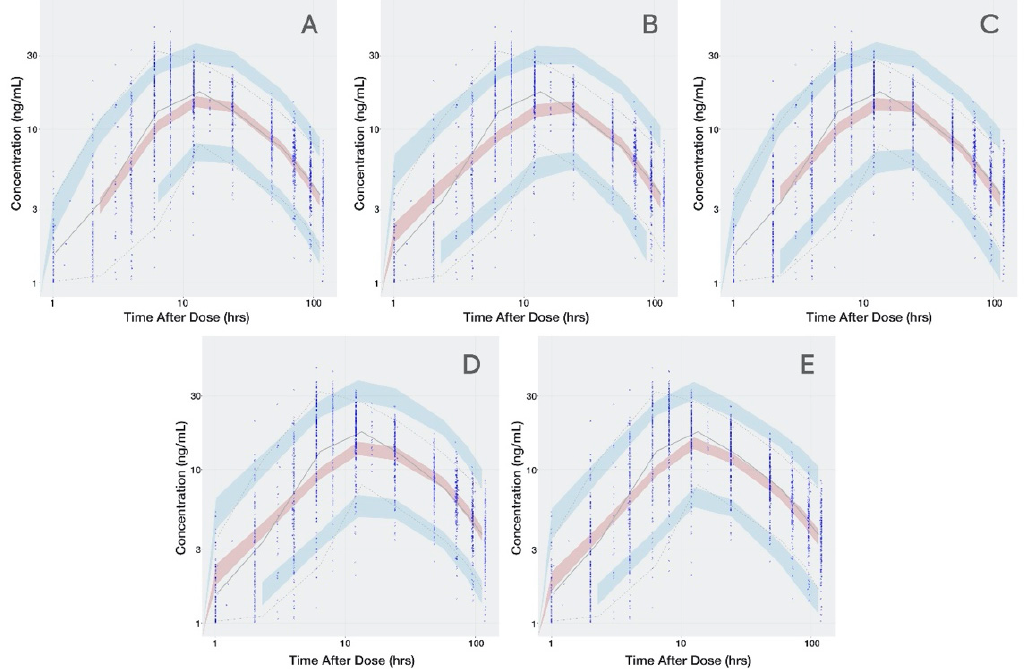
Figure 2. Visual Predictive Check for all Dacomitinib Base Models. ( A ): transit compartment model; ( B ): first-order absorption without lag time; ( C ): first-order absorption with lag time; ( D ): sequential but linked zero- and first-order absorption; ( E ): sequential independent zero- and first-order absorption. Time is presented in logarithmic scale to stretch the time around C max and better appreciate how well the absorption phase is captured. Observed data are presented in blue circles with the 50th percentile of the observed data represented by the solid blue line and the 5th and 95th percentiles of the observed data represented by the dotted blue lines. Red shaded region represents the prediction interval for the 50th percentile. Blue shaded regions represent the prediction intervals at the 5th and 95th percentiles. Table 3. Parameter Estimates for Dacomitinib Base Structural Models.